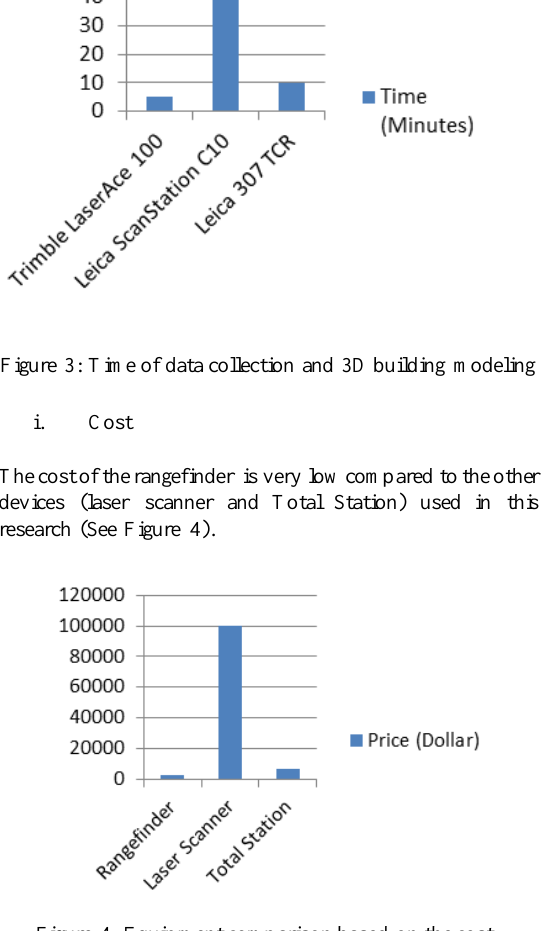
Figure 4: Equipment comparison based on the cost. i.